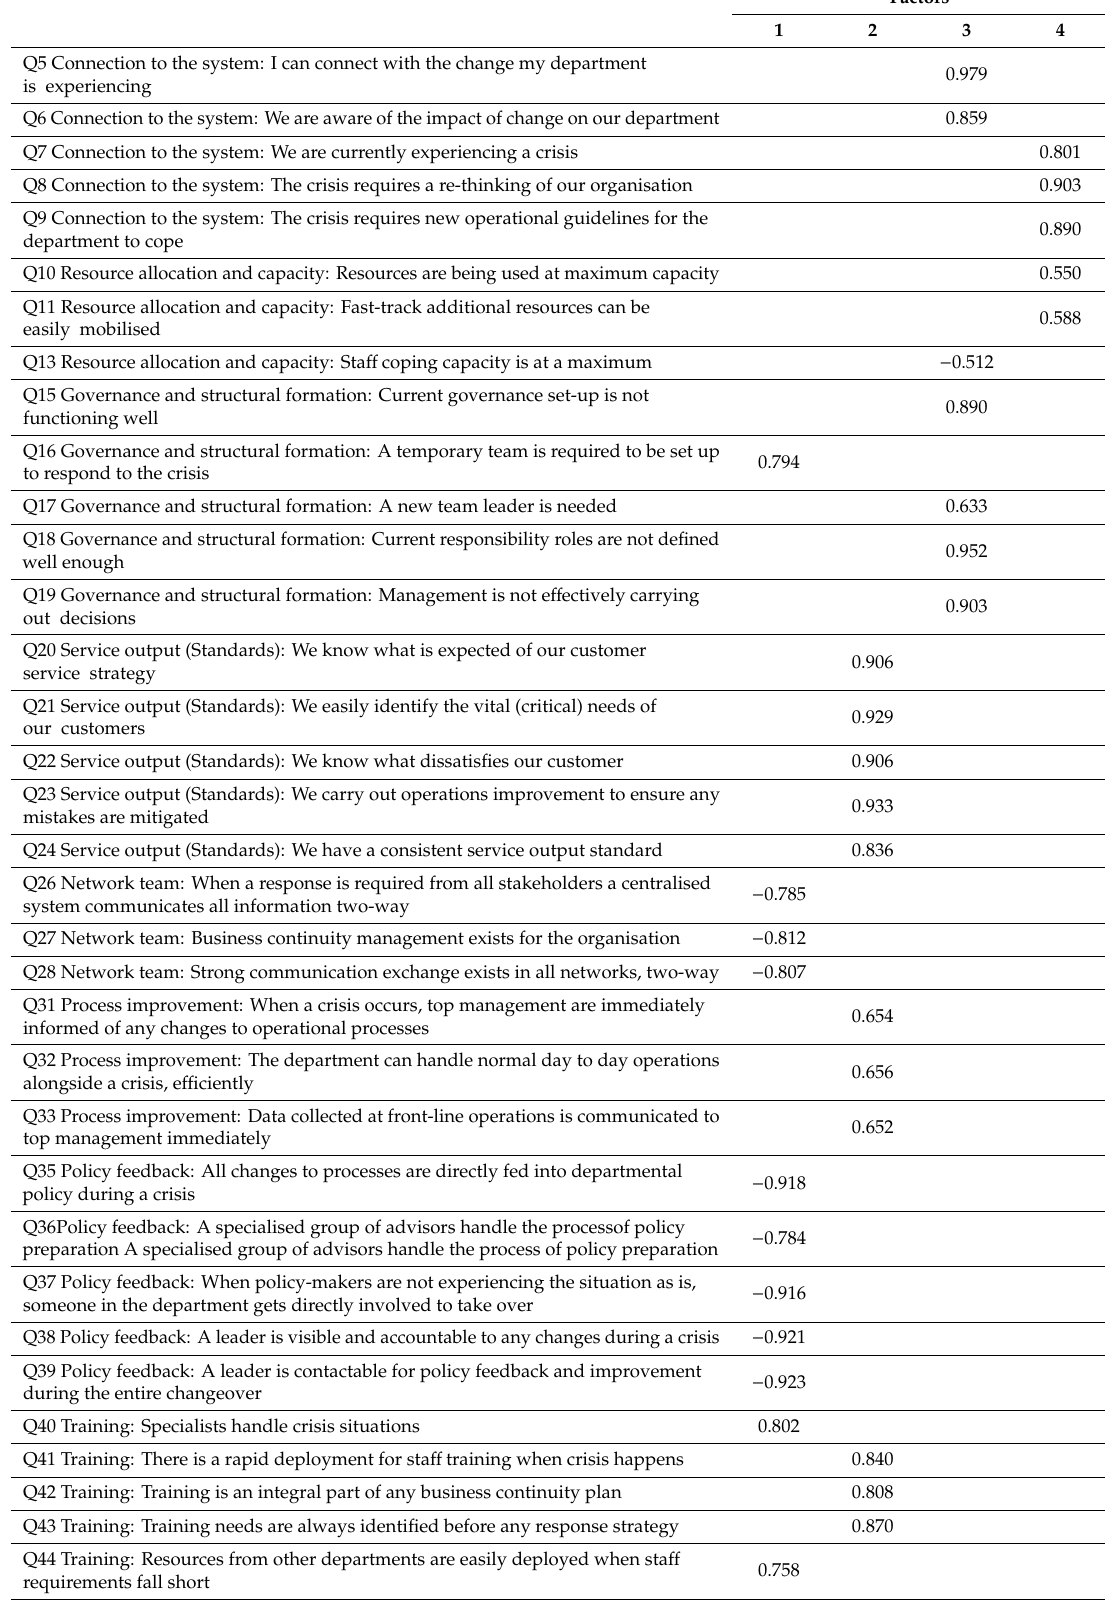
Table 1. Factors a .